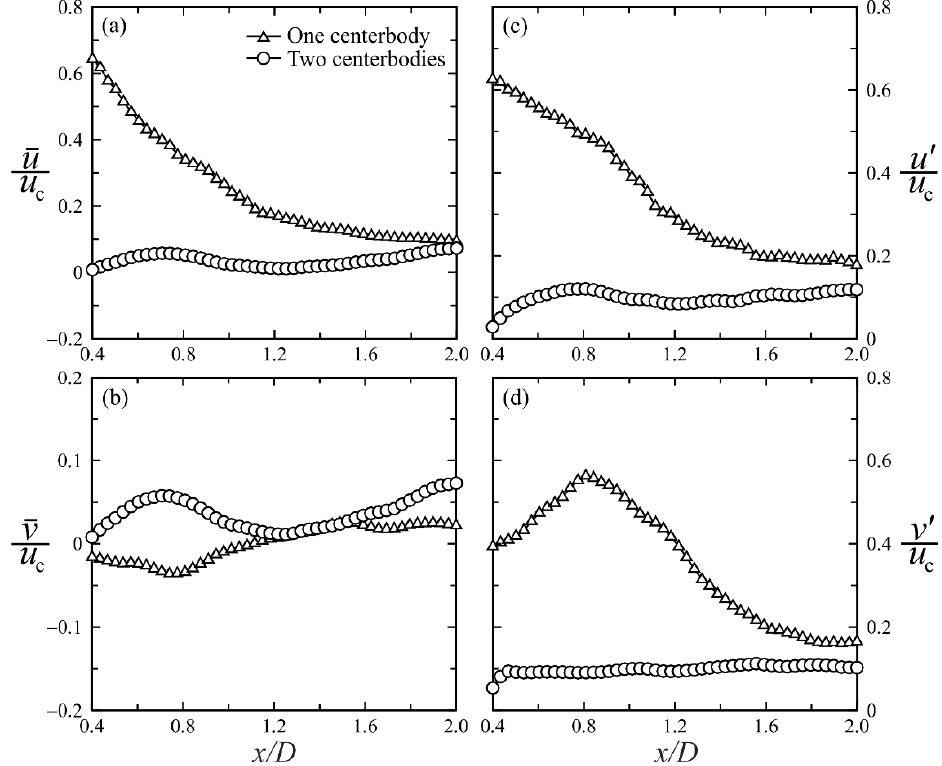
Figure 7. Normalized time-averaged velocities and velocity fluctuation intensities along central line. Re c = 280, Re a = 480, and S = 0.432. ( a ) Axial mean velocities, ( b ) radial mean velocities, ( c ) axial fluctuation intensities, ( d ) radial fluctuation intensities.